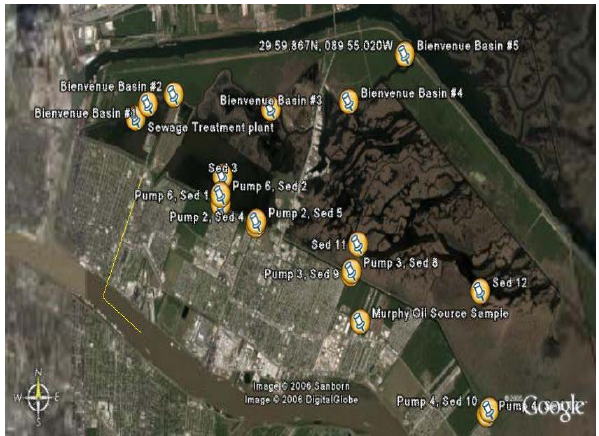
Figure 3: Map illustrating the sediment core locations with respect to the sewage treatment plant and stations that pumped flood water over the levee and into Violet Marsh. The GPS coordinates for the core locations are given in Table